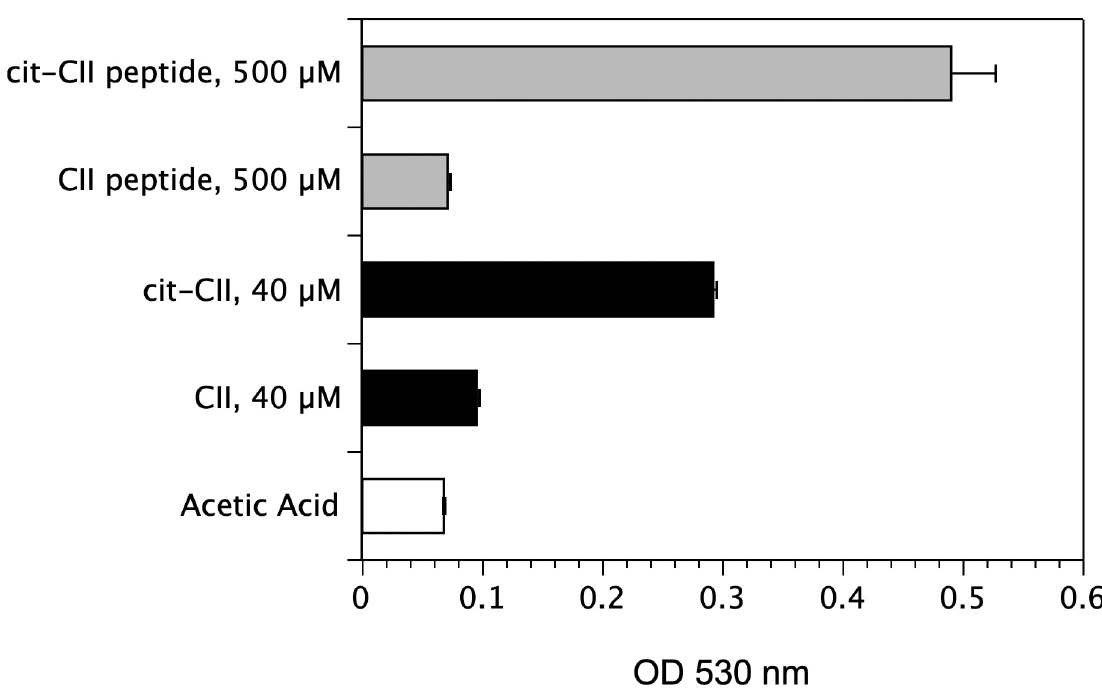
Fig 7. Measurement of PAD4-meidated citrullination of CII. Native bovine CII was citrullinated using PAD4, and the degree of citrullination achieved was measured using a colorimetric assay and absorbance at 530 nm. Cit-CII peptide was produced synthetically and used for comparison. All samples were dissolved in 10 mM acetic, and this reagent was used as the negative control. Data represent triplicate measurements, and error bars represent standard deviation.